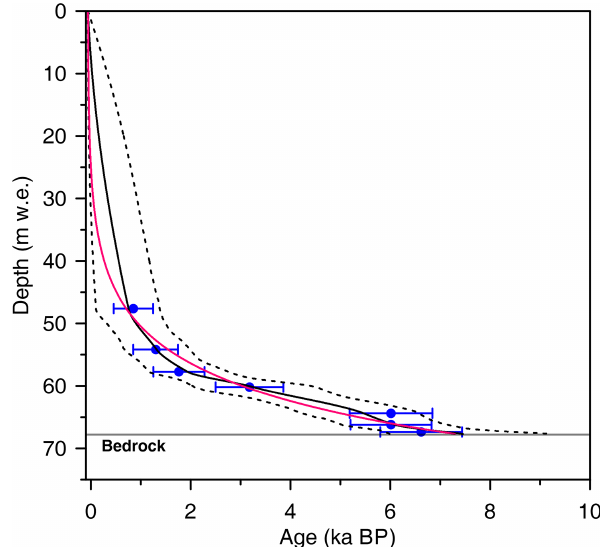
Figure 3. The age–depth relationships of the SLNS ice core based on 2000 Monte Carlo simulations fitting the absolute dated age hori- zons. The solid black line indicates the model mean, and the dotted lines indicate the 1 σ confidence interval. The blue dots stand for the calibrated 14 C ages with 1 σ error bars. The red line shows the depth–age profile modeled by an exponential